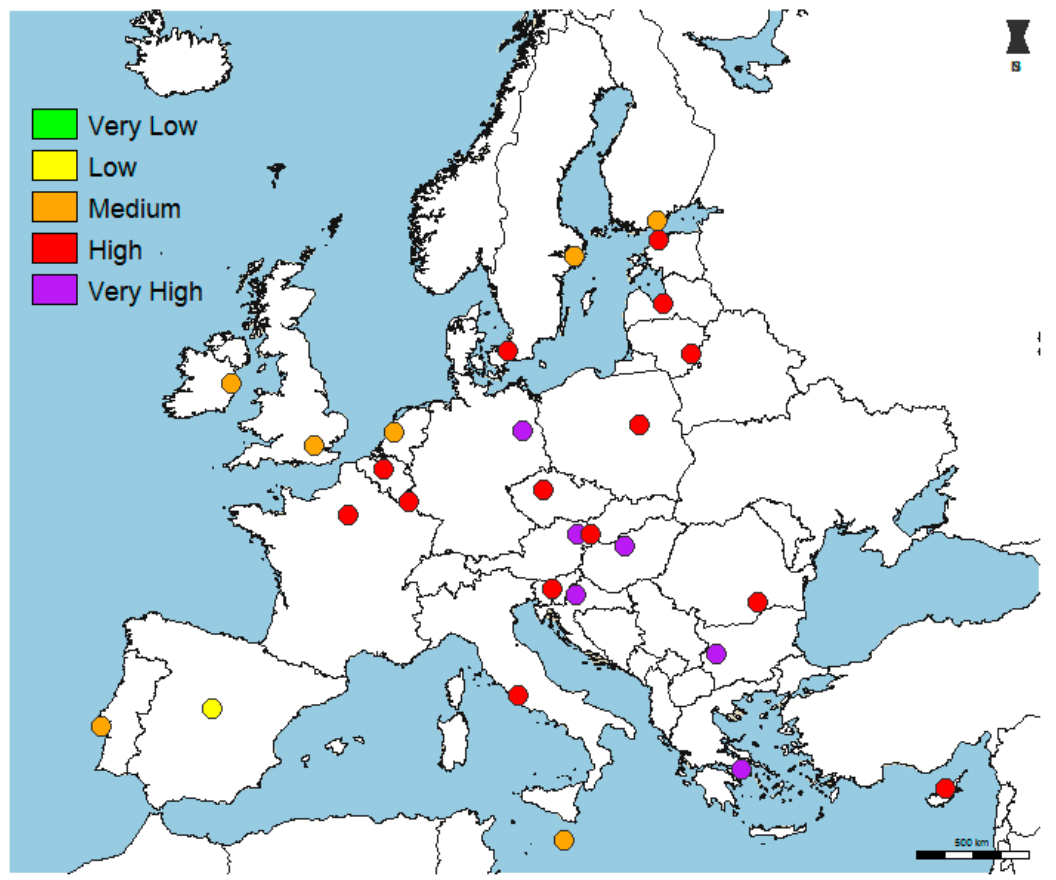
Figure 2. The Heatwave Hazard Index (HWHI) in the capitals of the 28-EU Member States during the 18-year sub-period 1998–2015. The color keys indicate the five HWHI risk-levels. The city-specific percentage change in the HWHI during the sub-period 1998–2015 compared with the sub-period 1980–1997 is shown in Figure 3. Decreases in HWHI were observed, especially in the two Southwestern capitals, with 10% and 43% HWHI decreases in Lisbon and Madrid respectively during the sub-period 1998–2015 compared to the previous 18-year sub-period. Small HWHI decreases (4%) were also observed in Dublin and Amsterdam (Figure 3). Most of the northern EU capitals (6 out of 8 northern cities) revealed a small increase of the HWHI (0% ≤ HWHI% change < 50%). Small HWHI increases were also observed in two western (Paris and Brussels) cities, and one eastern (Bratislava) and one southern (Valletta) city. Moderate HWHI increases (50% ≤ HWHI% change < 100%) were observed in eastern and western cities generally, as well as in one southern (Rome) and one northern (Vilnius) city. High and very high HWHI increases only occurred in central- eastern and southeastern capitals (red area in Figure 3): the HWHI more than doubled during the sub-period 1998–2015 in Vienna, Budapest, Ljubljana, Budapest, and Nicosia, and even more than tripled in Zagreb and Athens compared to the sub-period 1980–1997. By using the average HWHI percentage change (among all the EU capitals of a specific European geographic area) the highest average HWHI increase in the sub-period 1998–2015 compared to the sub-period 1980–1997 was observed in the eastern European capitals (76%), followed by southern (63%) and western (47%) European cities. The lowest HWHI% increase was observed in northern EU capitals (22%).